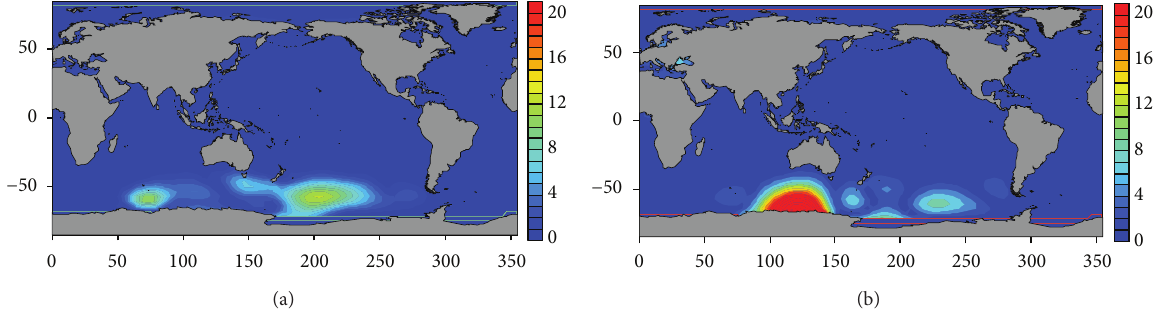
Figure 13: The spatial distributions of RMSEs of SST using (a) GDF and (b) DF with 𝑎, 𝑏 = 0.5